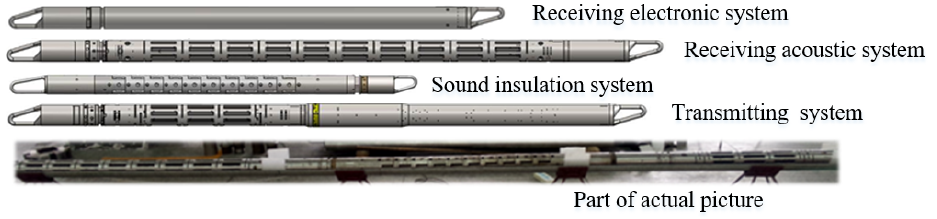
Figure 5. Structural diagram and part of the actual picture of the logging tool.